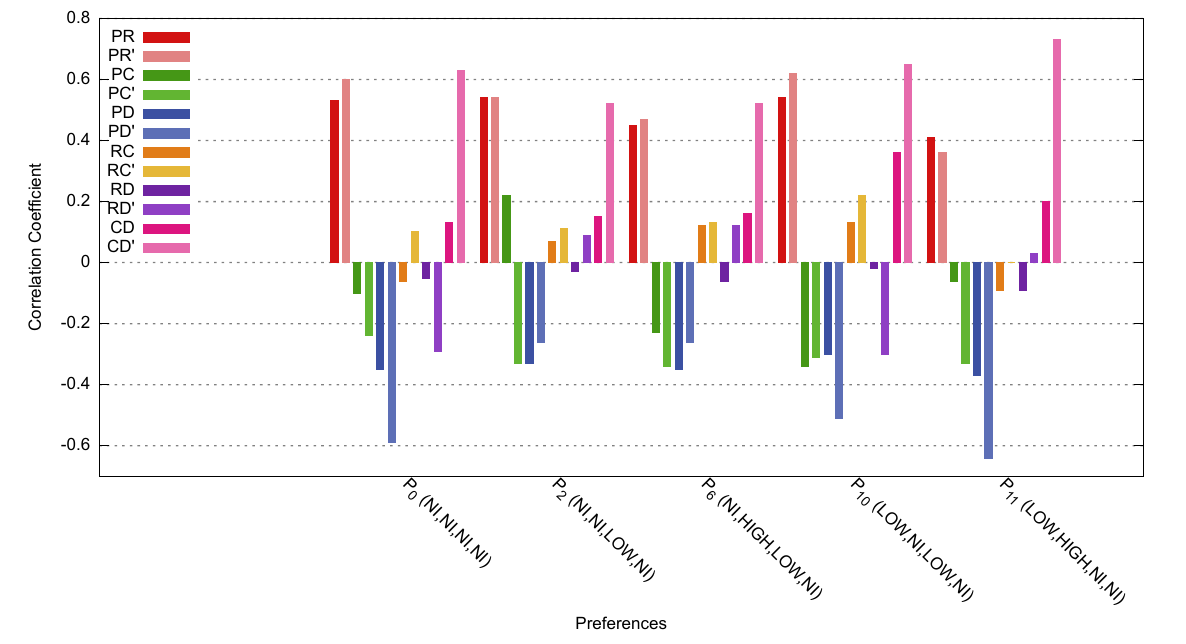
Figure 9. Comparison for the attribute’s correlation coefficient for each preference.